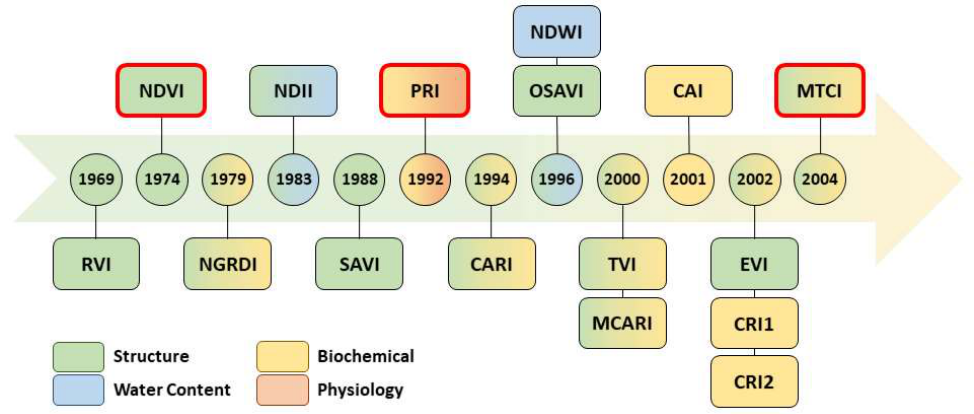
Figure 4. Development of spectral reflectance-based vegetation indices. RVI: Ratio vegetation index; NDVI: Normalized di ff erence vegetation index; NGRDI: Normalized red-green di ff erence index; NDII: Normalized di ff erence infrared index; SAVI: Soil-adjusted vegetation index; PRI: Photochemical